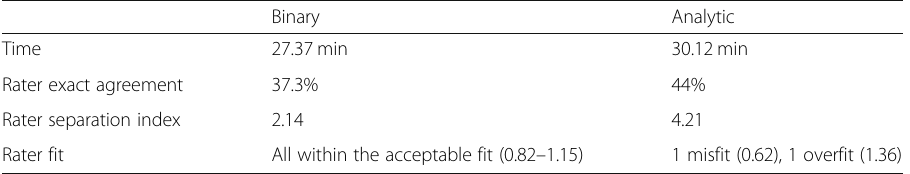
Table 4 Binary and analytic scale comparison Binary Analytic Time 27.37 min